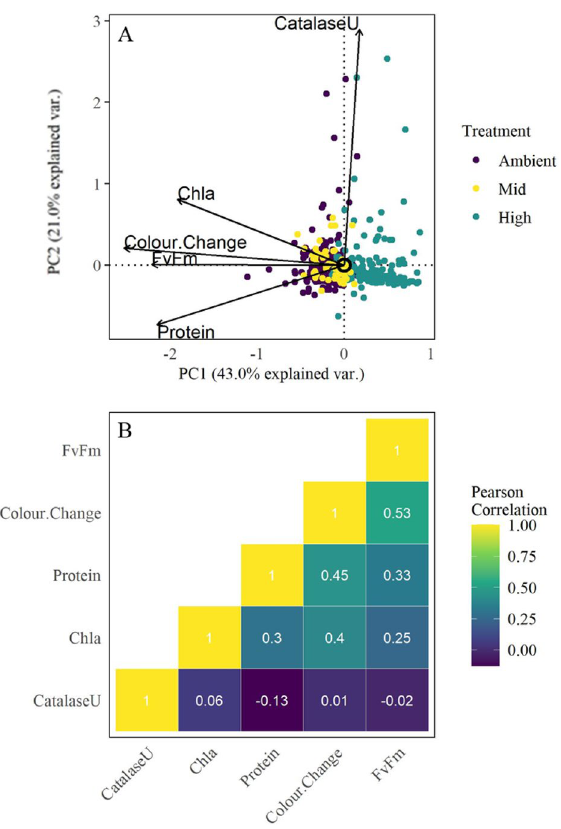
Figure 3. Relationships between multiple physiological responses to heat stress in A. tenuis . ( A ) Principal Component Analysis (PCA) of five physiological traits in response to acute heat stress in A.tenuis (n reefs = 7, n samples = 423) and ( B ) correlation heatmap between all traits. Yellow diagonal are self-comparisons.